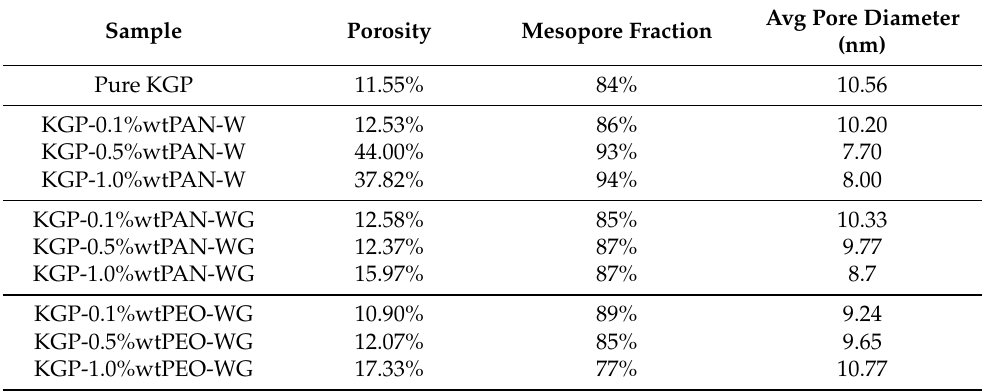
Table 5. Porosity results of electrospun-fiber-reinforced geopolymer composites from MIP